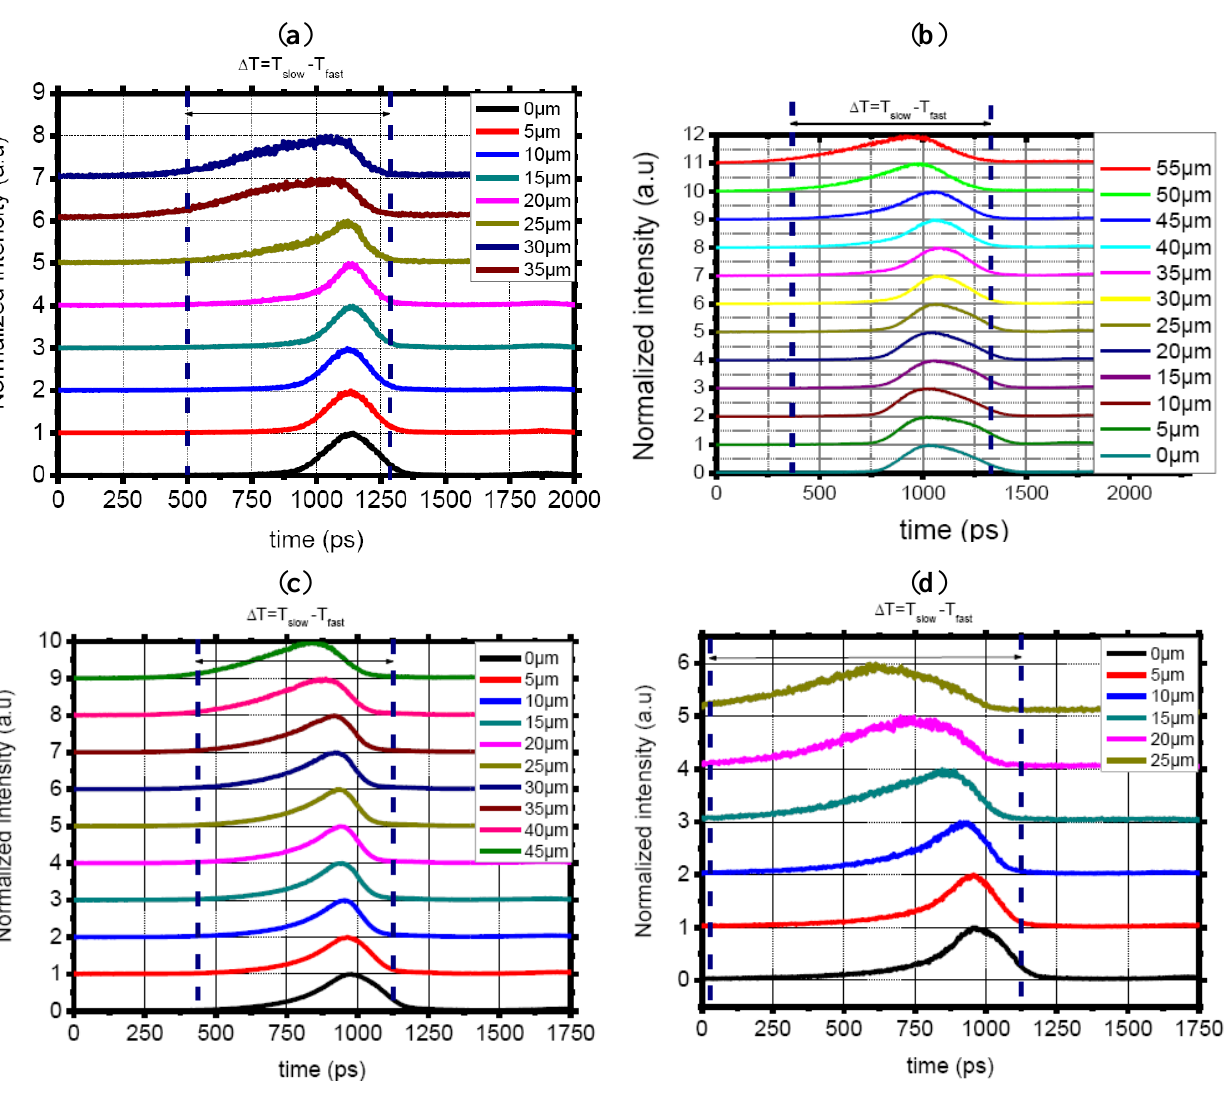
Figure 9. DMD scanning of the four PFGI-POF at 850 nm (length: 200